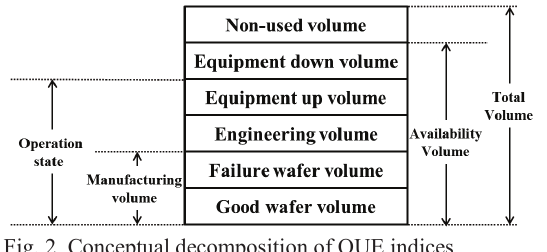
Fig. 2 Conceptual decomposition of OUE indices